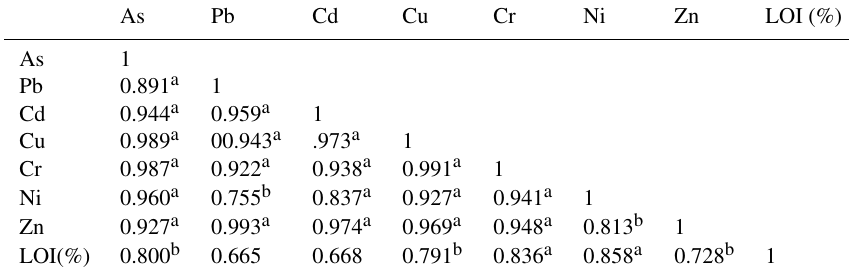
Table 4. Correlation coefficient matrix of trace elements and organic matter in sediments from the study area ( n = 16). LOI: loss on ignition. As